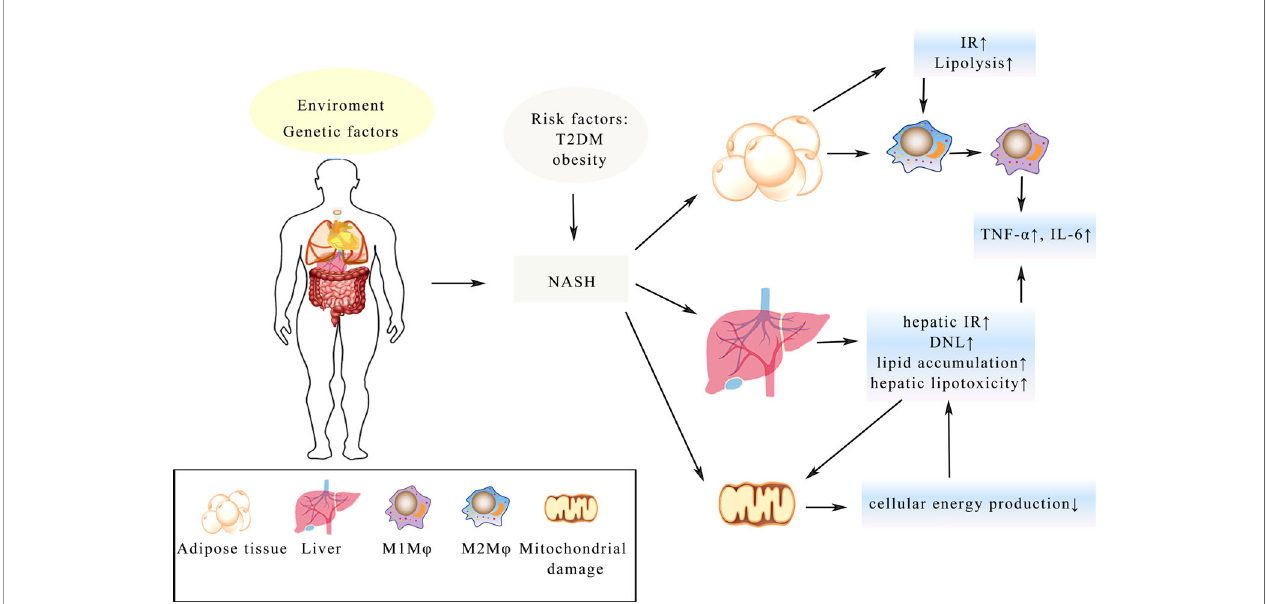
FIGURE 3 | Illustration of the complex pathologic processes of NASH. T2DM and obesity increase the risk of NASH. IR in the adipose tissue and liver is a key driver, which leads to the imbalance of metabolism. Mitochondrial damage leads to less cellular energy production and adipose tissue hypertrophy, resulting in M j changing from the anti-in fl ammatory M2 M j state into the pro-in fl ammatory M1 M j . The process of all these changes will lead to enhance secretion of TNF- a , IL-6 and lipid accumulation in the hepatocyte, which eventually develop into fi brosis and